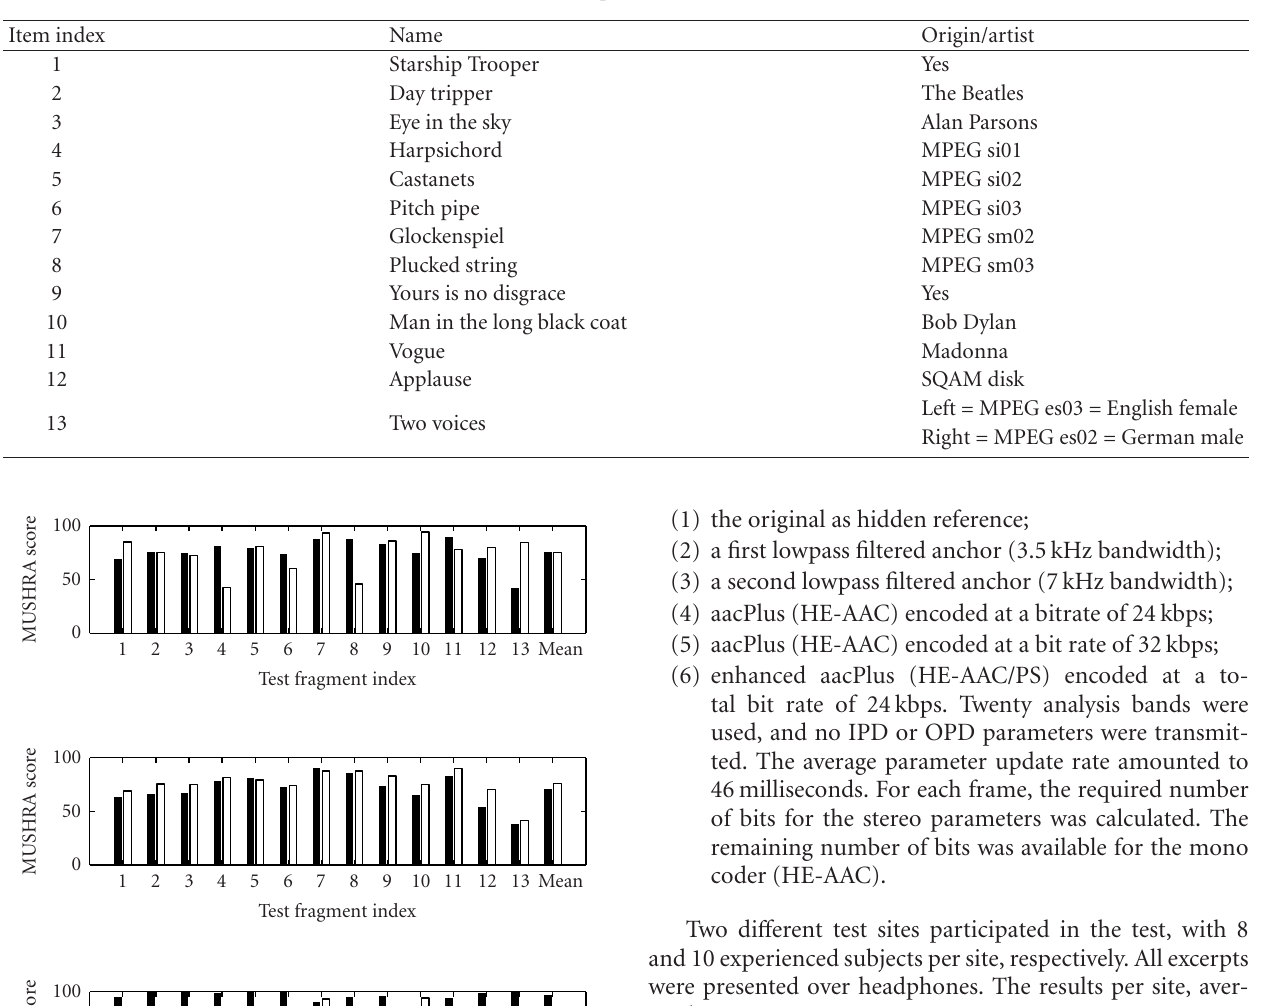
Table 3: Description of test material.